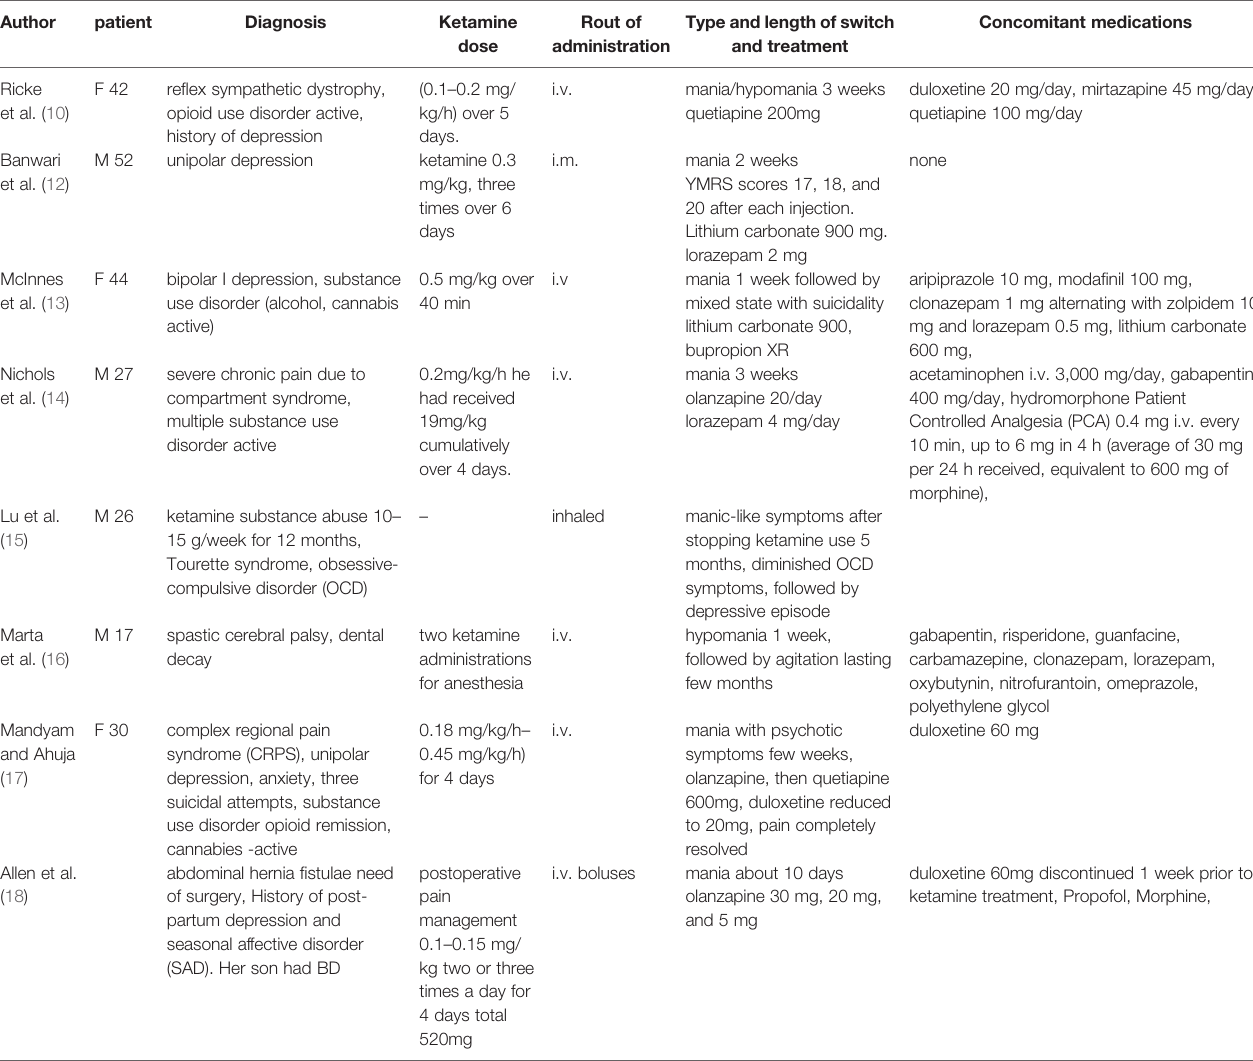
TABLE 2 | Previous cases reporting affective switch associated to